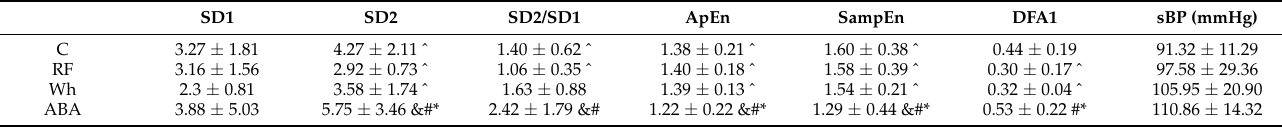
Table 6. HRV nonlinear measures. Data expressed as mean ± SD. Statistically significant difference marked as: &—vs. C, #—vs. RF, *—vs. Wh, ˆ—vs. ABA. SD1 SD2